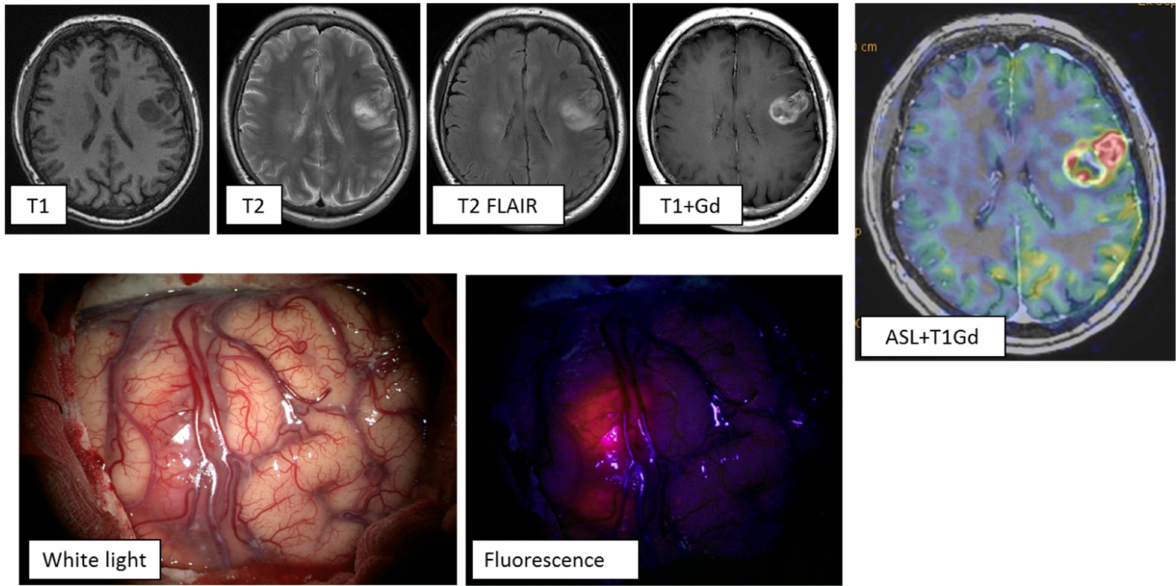
Figure 3. MRI study of a patient with multiple primary glioblastomas. ASL perfusion in the tumor of the left frontal lobe revealed areas of hyperperfusion: TBF = 289.7 mL/100 g/min. Tumor demonstrated vivid contrast enhancement. During surgery using fluorescence diagnostics, this tumor showed an intense glow.